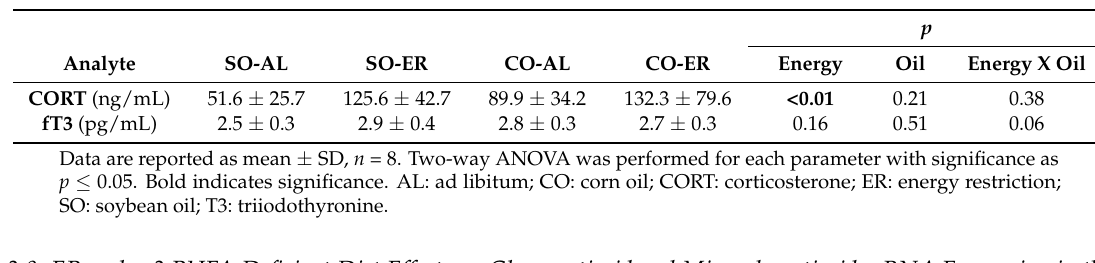
Table 7. Plasma concentrations of CORT and